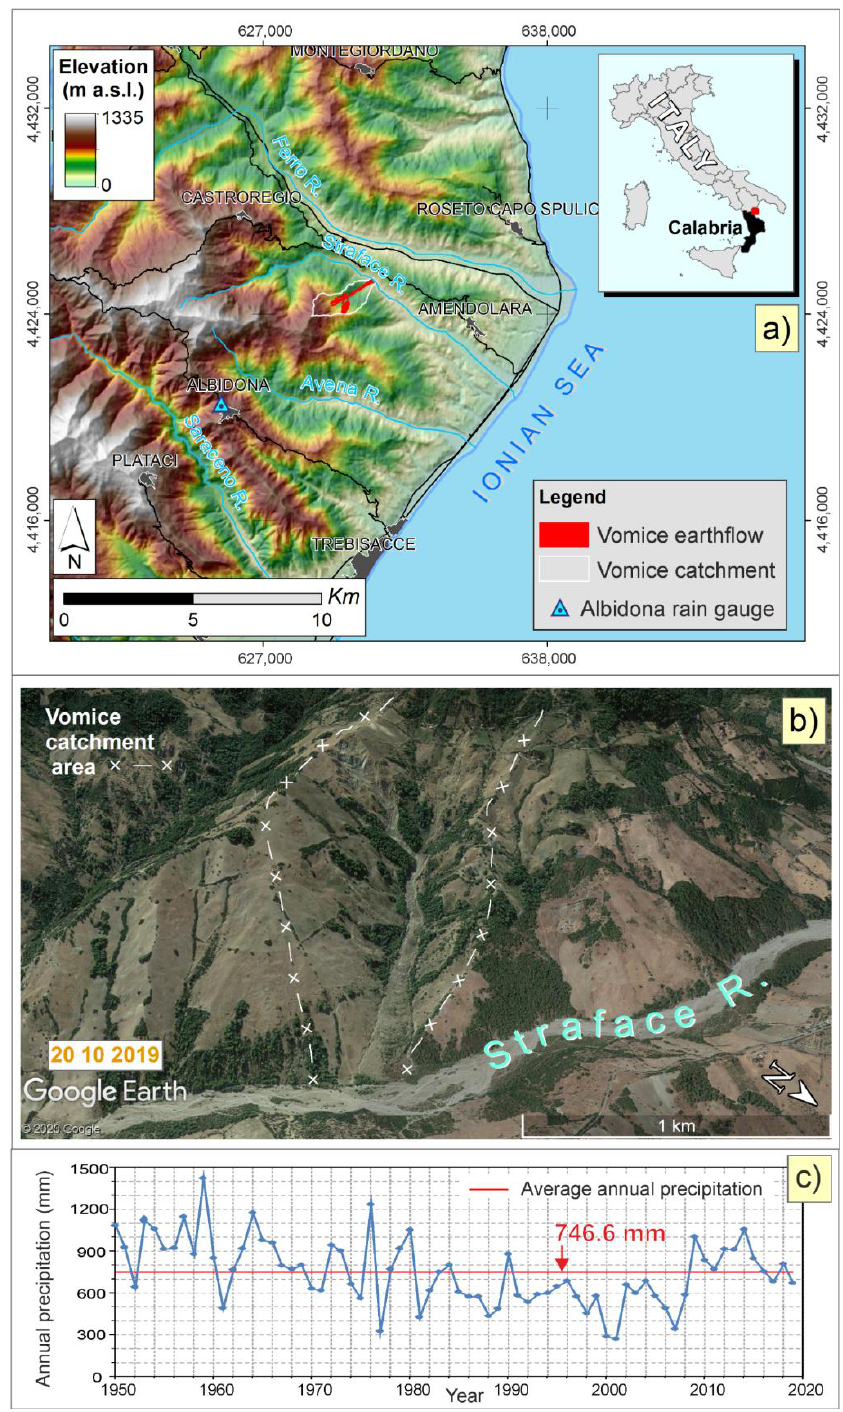
Figure 1. Location of study area ( a ), Google Earth image of the Vomice catchment ( b ), and annual precipitation (Albidona rain gauge, 790 m a.s.l.) from 1950 to 2019 ( c ).